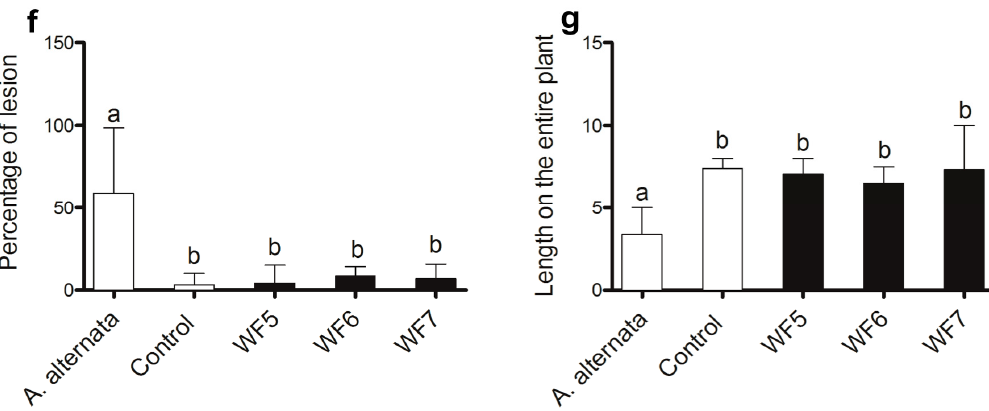
Figure 2. Plant pathogenicity assay of each putative endophyte following inoculation onto finger millet. ( a ) Representative picture showing the effect of the known pathogen Alternaria alternata on finger millet seedlings (positive control); ( b ) Representative picture showing the effect of buffer on finger millet seedlings (negative control); ( c – e ) Representative pictures showing the effect of the each putative fungal endophyte on finger millet seedlings as indicated; ( f ) Quantification of the percentage of lesions caused by each fungus or the pathogen Alternaria alternata compared to the control using Assess software; ( g ) Quantification of the total length of finger millet seedlings inoculated with each endophytic fungus or the pathogen Alternaria alternata compared to the control. For both ( f ) and ( g ), letters that are different from one another indicate that their means are statistically different (Mann-Whitney t -test, p ≤ 0.05). The whiskers indicate the standard error of the mean.